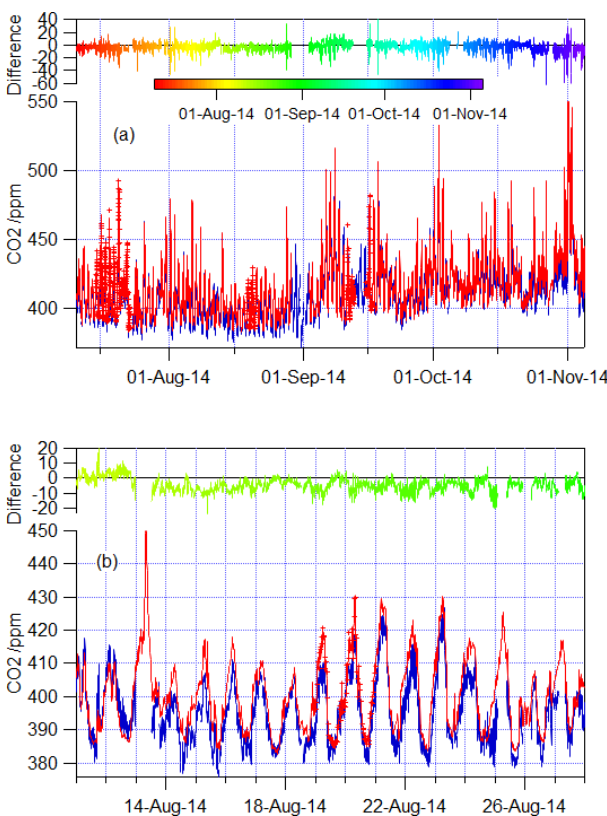
Figure 9. Open-path (blue), in situ (red) and difference (OP – in situ, coloured by time) measurements of CO 2 . All raw OP data have been reduced by a factor of 1.025 ( ∼ 10ppm) to remove measure- ment bias relative to the in situ data. In the corrected data, there is zero bias for wind speeds > 6ms − 1 over the entire measurement period (see text for detail). (a) shows the whole measurement pe- riod. (b) illustrates a selected period with a consistent, real OP–in situ difference relative to the well mixed average.